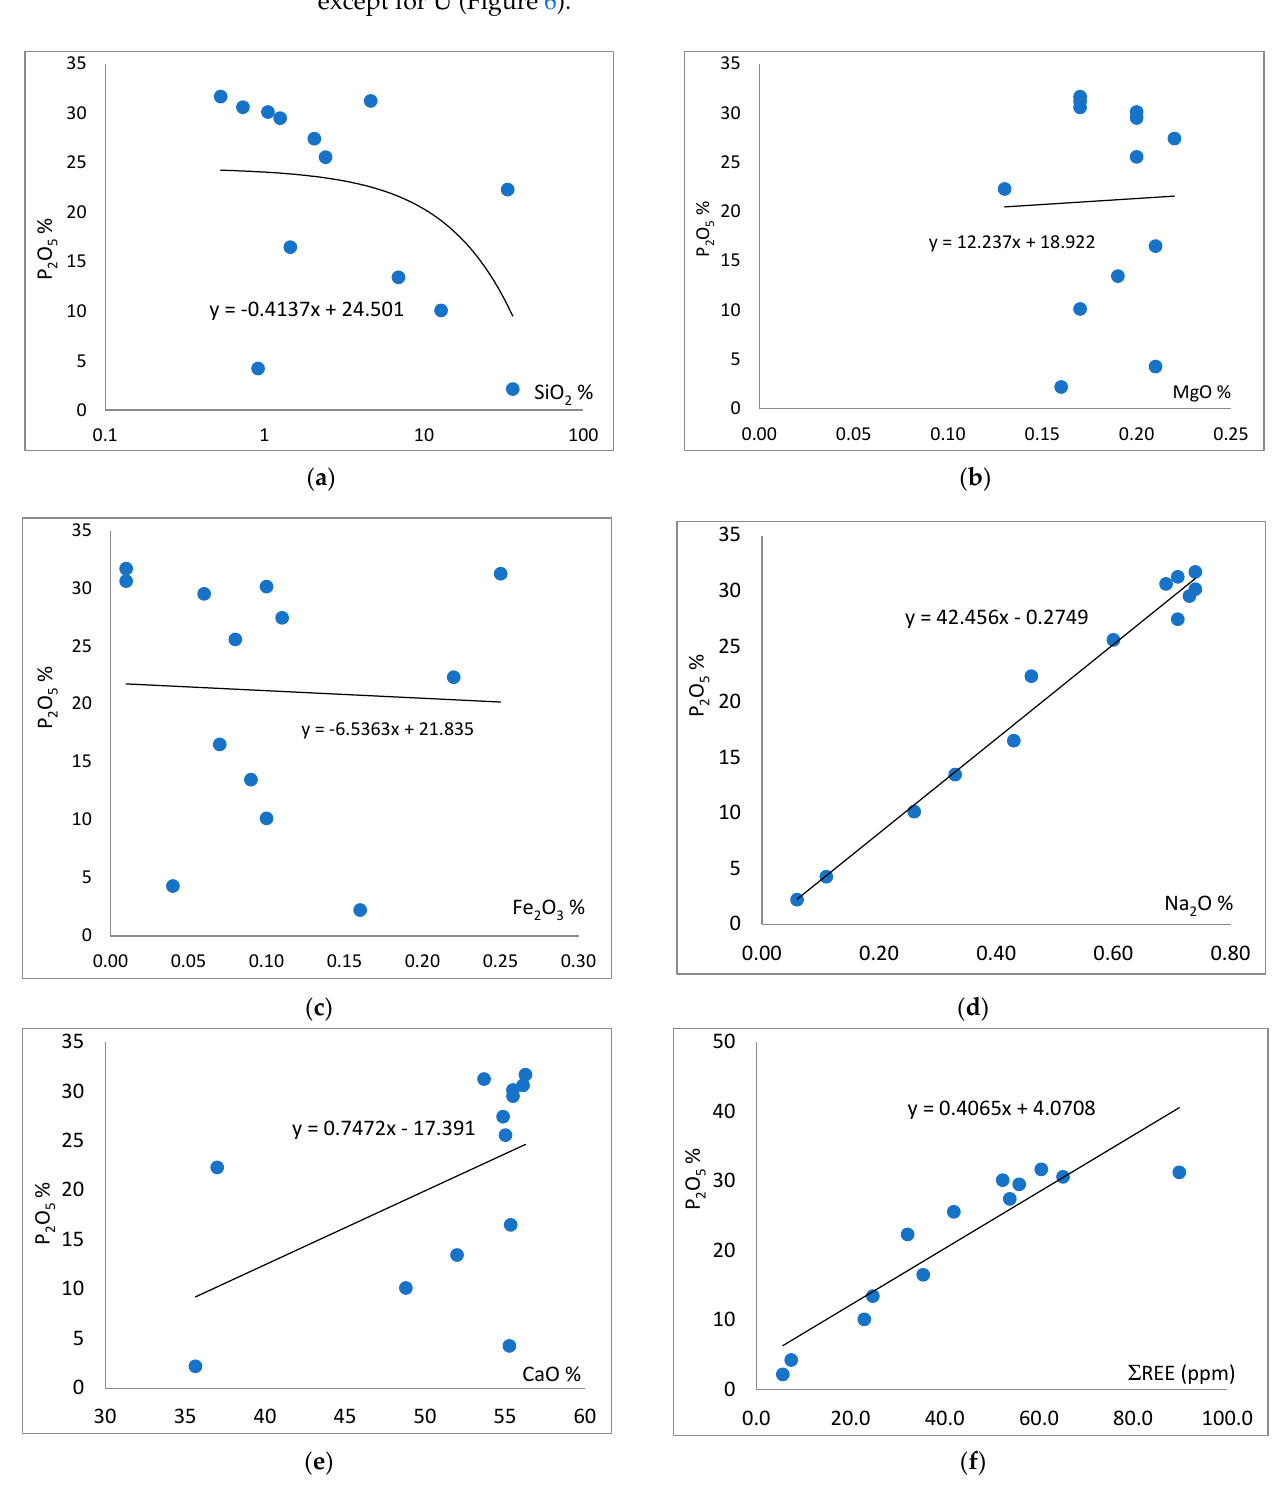
Figure 5. Binary major oxide plots; ( a ) P 2 O 5 % vs. SiO 2 ; ( b ) P 2 O 5 vs. MgO; ( c ) P 2 O 5 vs. Fe 2 O 3 ; ( d ) P 2 O 5 vs. Na 2 O; ( e ) P 2 O 5 vs. CaO; ( f ) P 2 O 5 vs. ∑ REE.